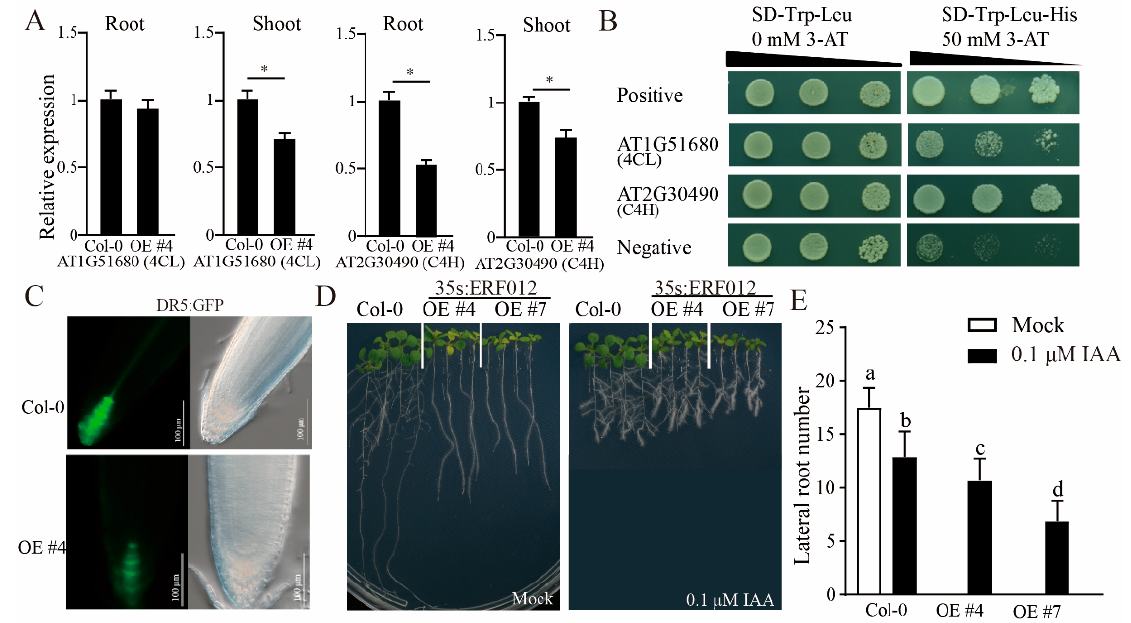
Figure 4. Overexpression of ERF012 regulates lateral root formation. ( A ) The expression of At4CL and AtC4H in 12-day-old Col-0 and ERF012 -overexpressing lines (OE #4). Values represent means ± SD, n = 3 pools, with about 20 plant roots per pool. Asterisks indicate significant differences between different plants: Student’s t -test, * p < 0.05. ( B ) ERF012 binds to the promoter of the At4CL and AtC4H . The promoter sequences of the 4CL and C4H were subcloned into the pHis2 vector and the ERF012 CDS sequence was subcloned into the pGADT7-rec2 vector for yeast one-hybrid assay. ( C ) The images of DR5:GFP in root tips of Col-0 and ERF012 -OE lines (OE#4). ( D ) Exogenous application of IAA (0.1 µ M) can effectively restore the lateral root formation. The 5-day-old seedlings were transferred to the medium supplemented with or without IAA for 6 days of growth. ( E ) The lateral root number was statistically calculated in figure ( D ). Values represent means ± SD, n = 12. Letters indicate significant differences between different plants: Duncan’s test ( p < 0.05).